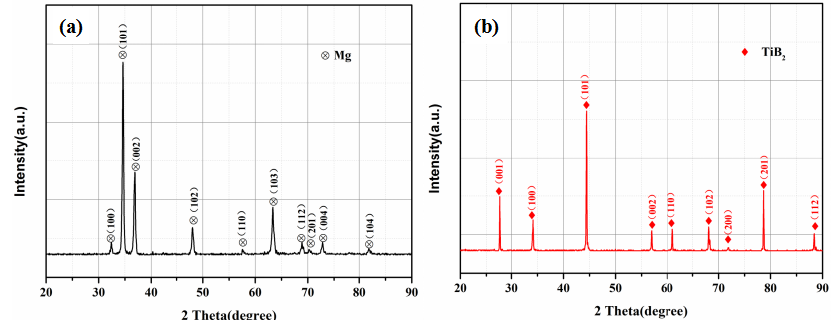
Figure 2. The XRD patterns of initial materials: ( a ) AZ31 Mg alloy chips and ( b )TiB 2 particles.